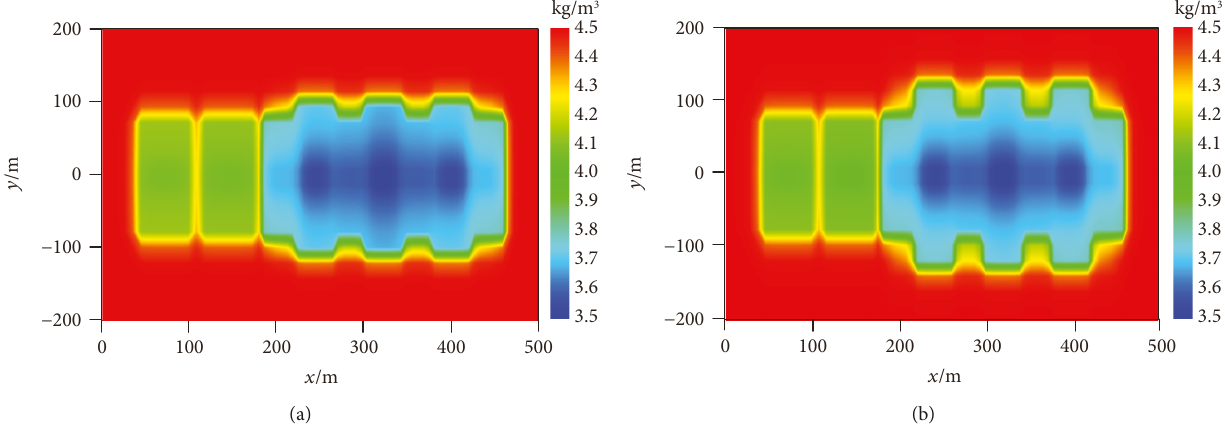
Figure 13: Reservoir adsorption gas content distribution: (a) 90m hydraulic fracture half-length and (b) 110 m hydraulic fracture half-length.